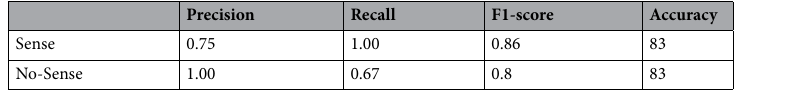
Table 2. EEG-based DNN comparison. The EEG based model reaches accuracy of 83% while maintaining a recall of 100% and precision of 75% in active-sense classification task.